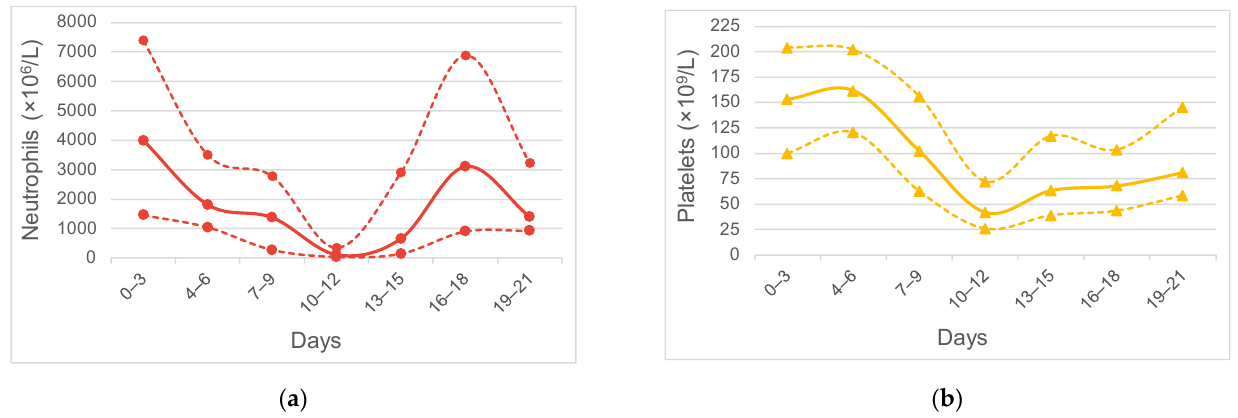
Figure 1. Hematological toxicity of 129 cycles of ic-VDC/IE in young Asian patients : ( a ) Neutrophil count of cycles; ( b ) Platelet count of cycles. Solid lines are median counts, and dashed lines are 25th% and 75th% counts, respectively.